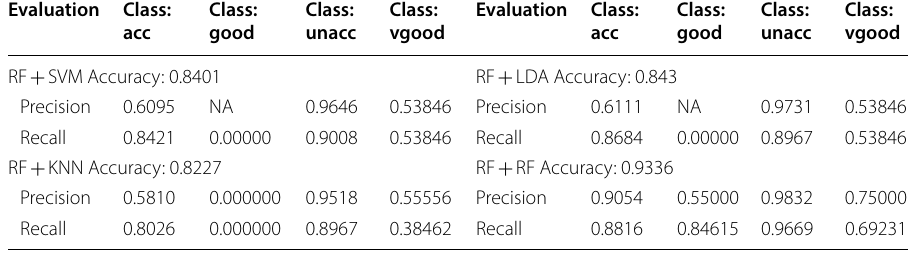
Table 11 Statistics by class of Different Classifiers with Car Evaluation Dataset (4 features)